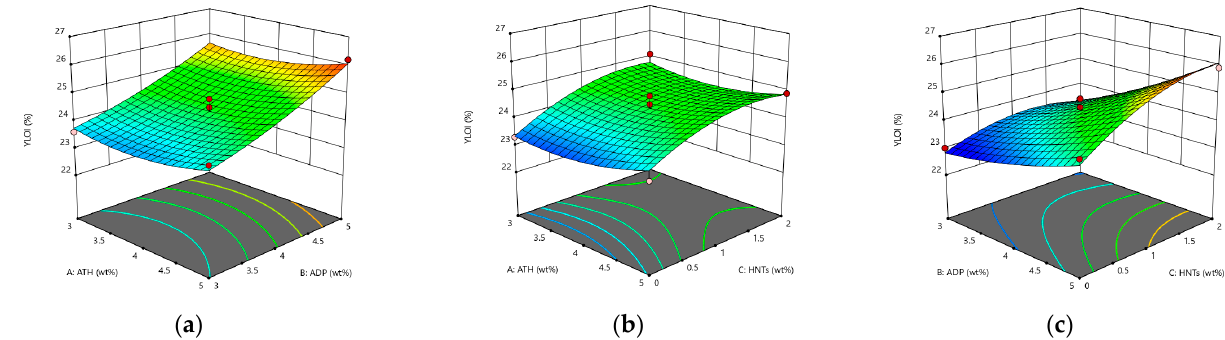
Figure 4. The response surface diagram of the flame retardant system to the change of LOI model: ( a ) Interactive effects of ATH and ADP; ( b ) Interactive effects of ATH and HNTs; and ( c ) Interactive effects of ADP and HNTs.